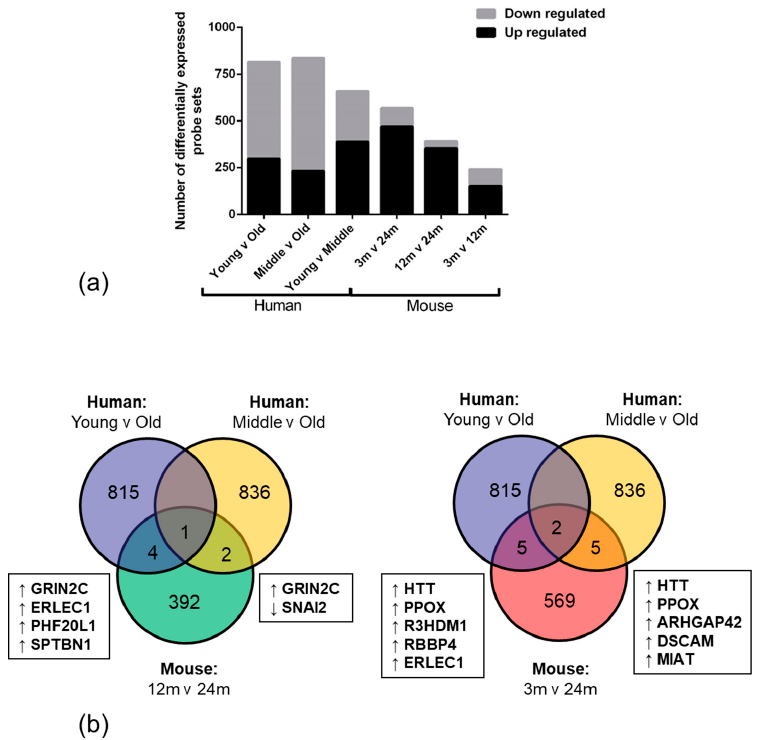
Figure 1. mRNA gene expression analysis. ( a ) Total number of significantly differentially expressed probe sets and the ratio of up to down regulated transcripts in an ageing human and mouse cohort. ( b ) The number of unique and overlapping significantly, differentially expressed genes between the human and mouse datasets. Common genes, dysregulated in the same direction, between species are listed. Up and down regulation compared to oldest age group are represented with directional arrows.